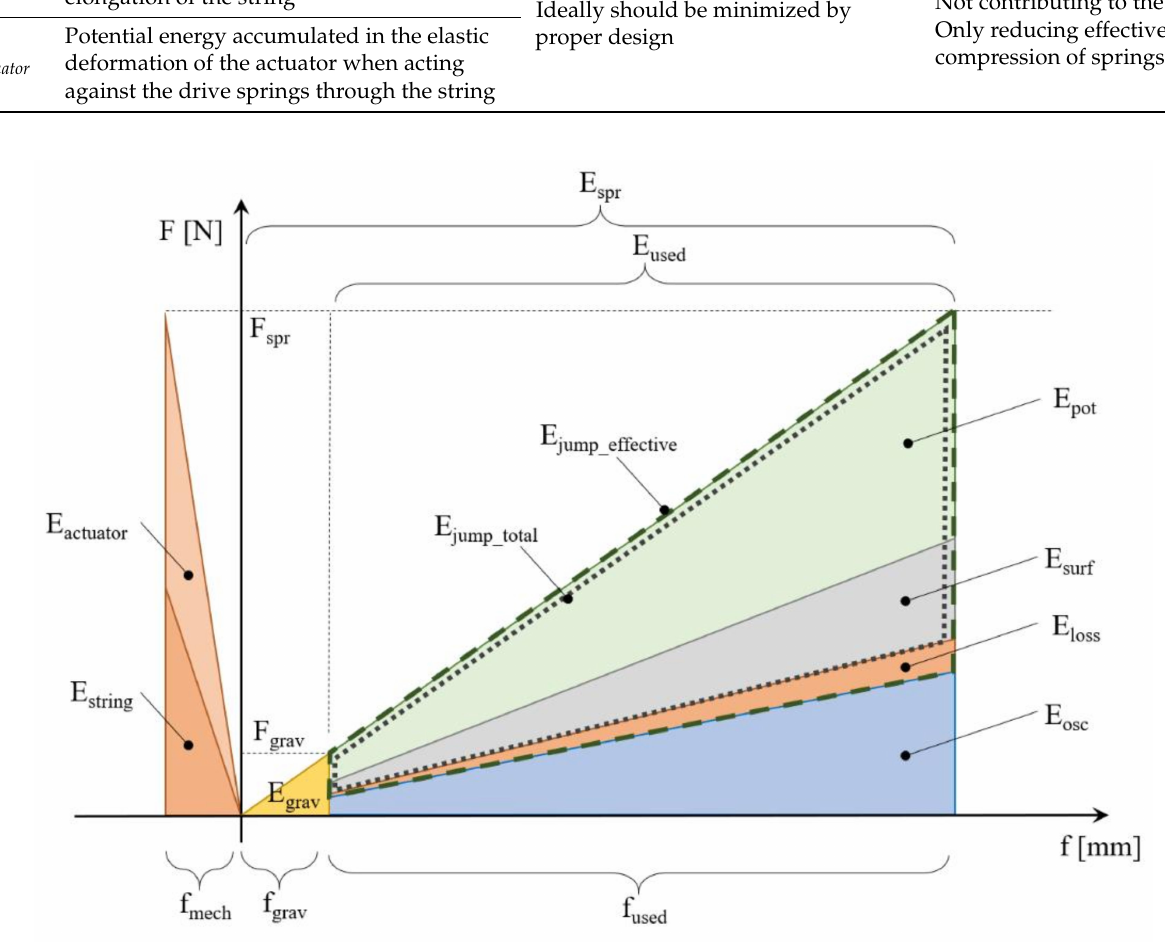
Figure 7. Energy contributions in the actuating mechanism and drive springs. The horizontal axis is mechanism (f mech ) and drive springs deflection ( f grav + f used ), the vertical axis is the drive spring reaction